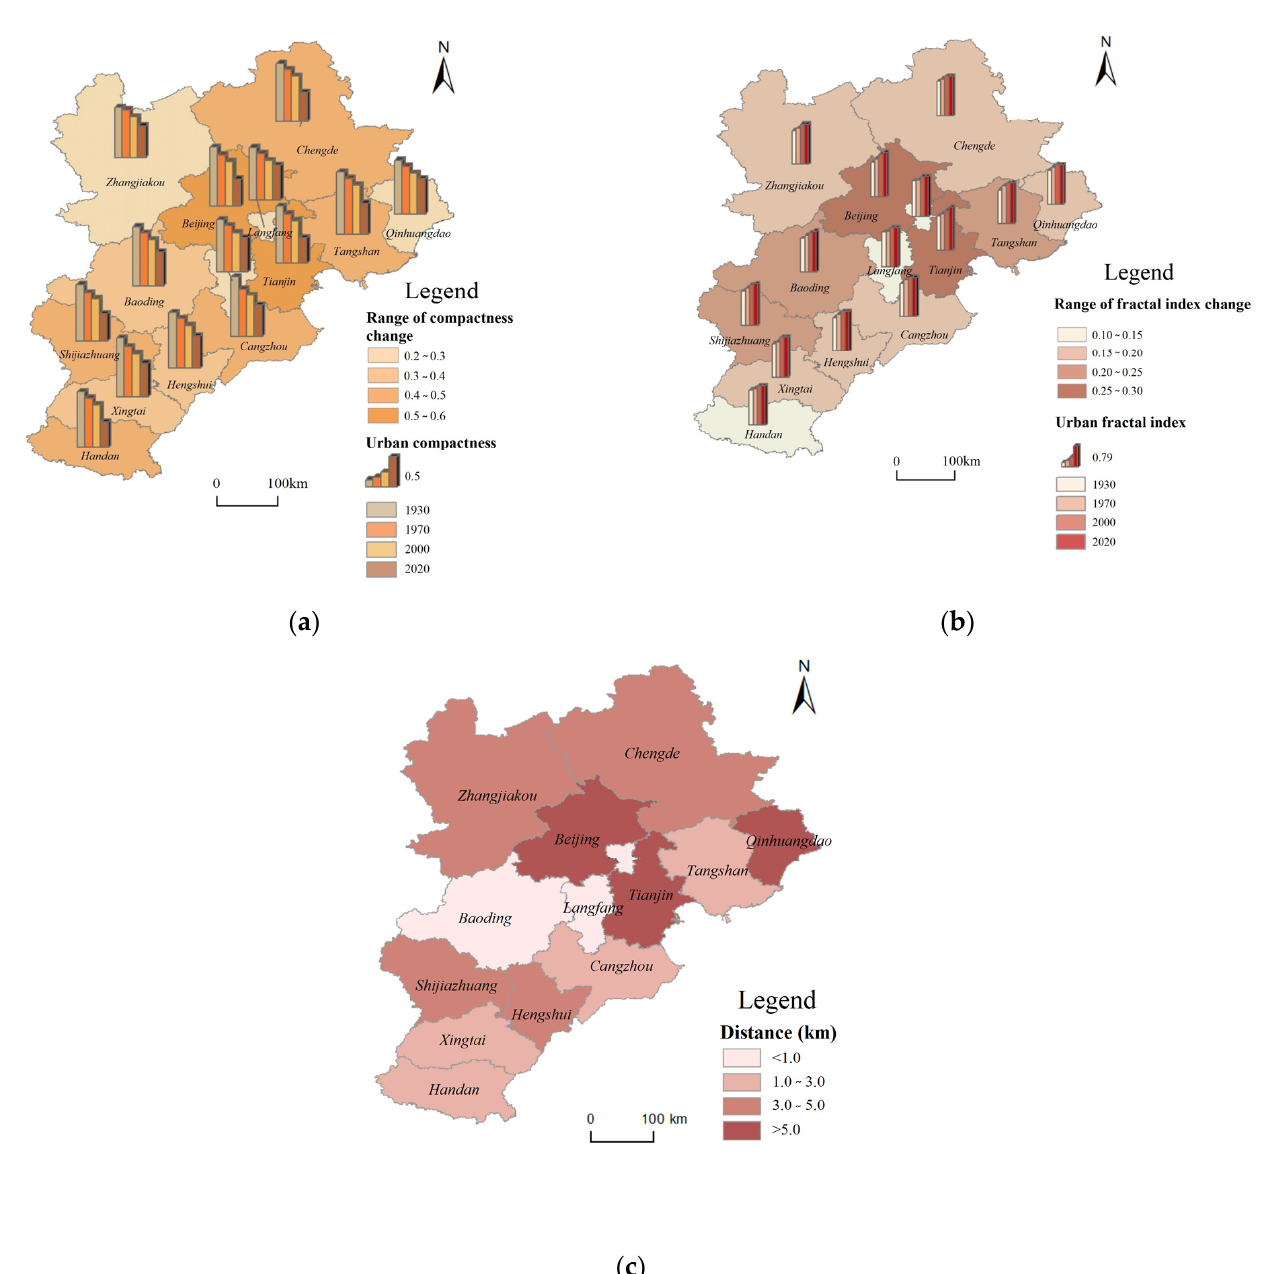
Figure 8. Changes in urban form: ( a ) urban compactness; ( b ) fractal dimension; ( c ) distance of the city mean